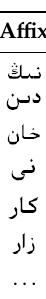
Table 1. Set of Uyghur affixes.